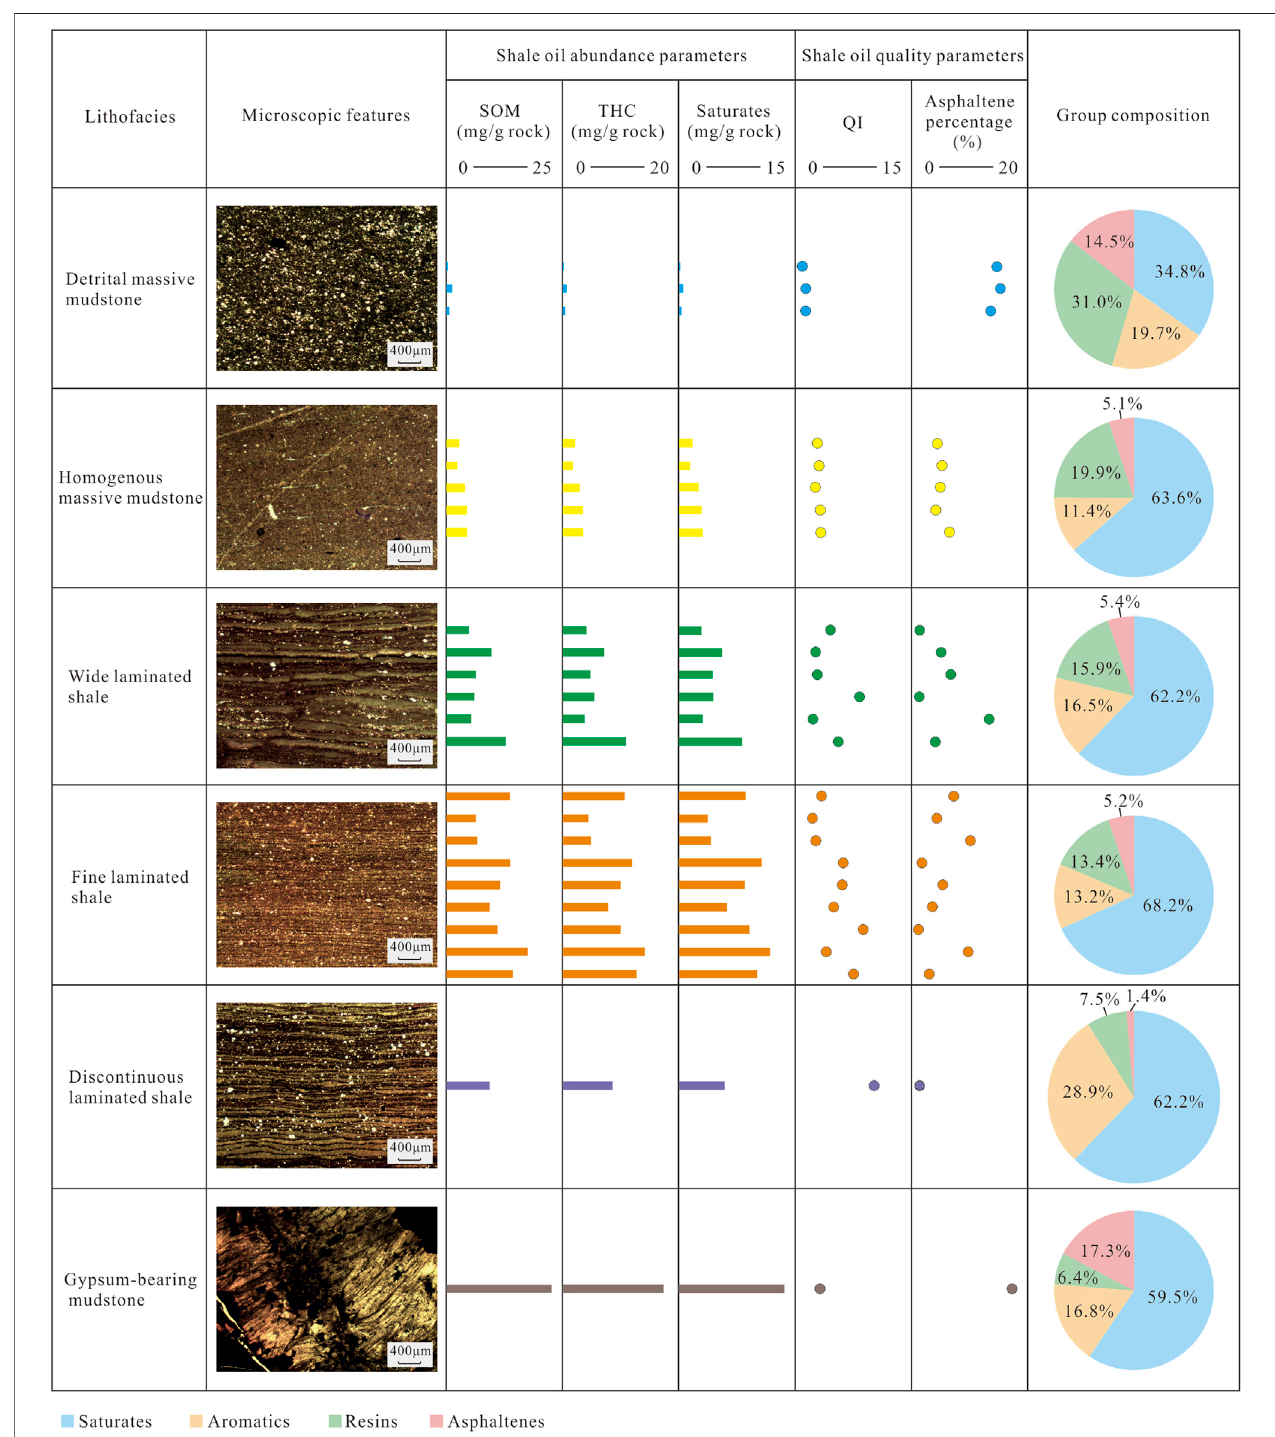
FIGURE 12 | Comprehensive evaluation of shale oil in shales with different lithofacies.